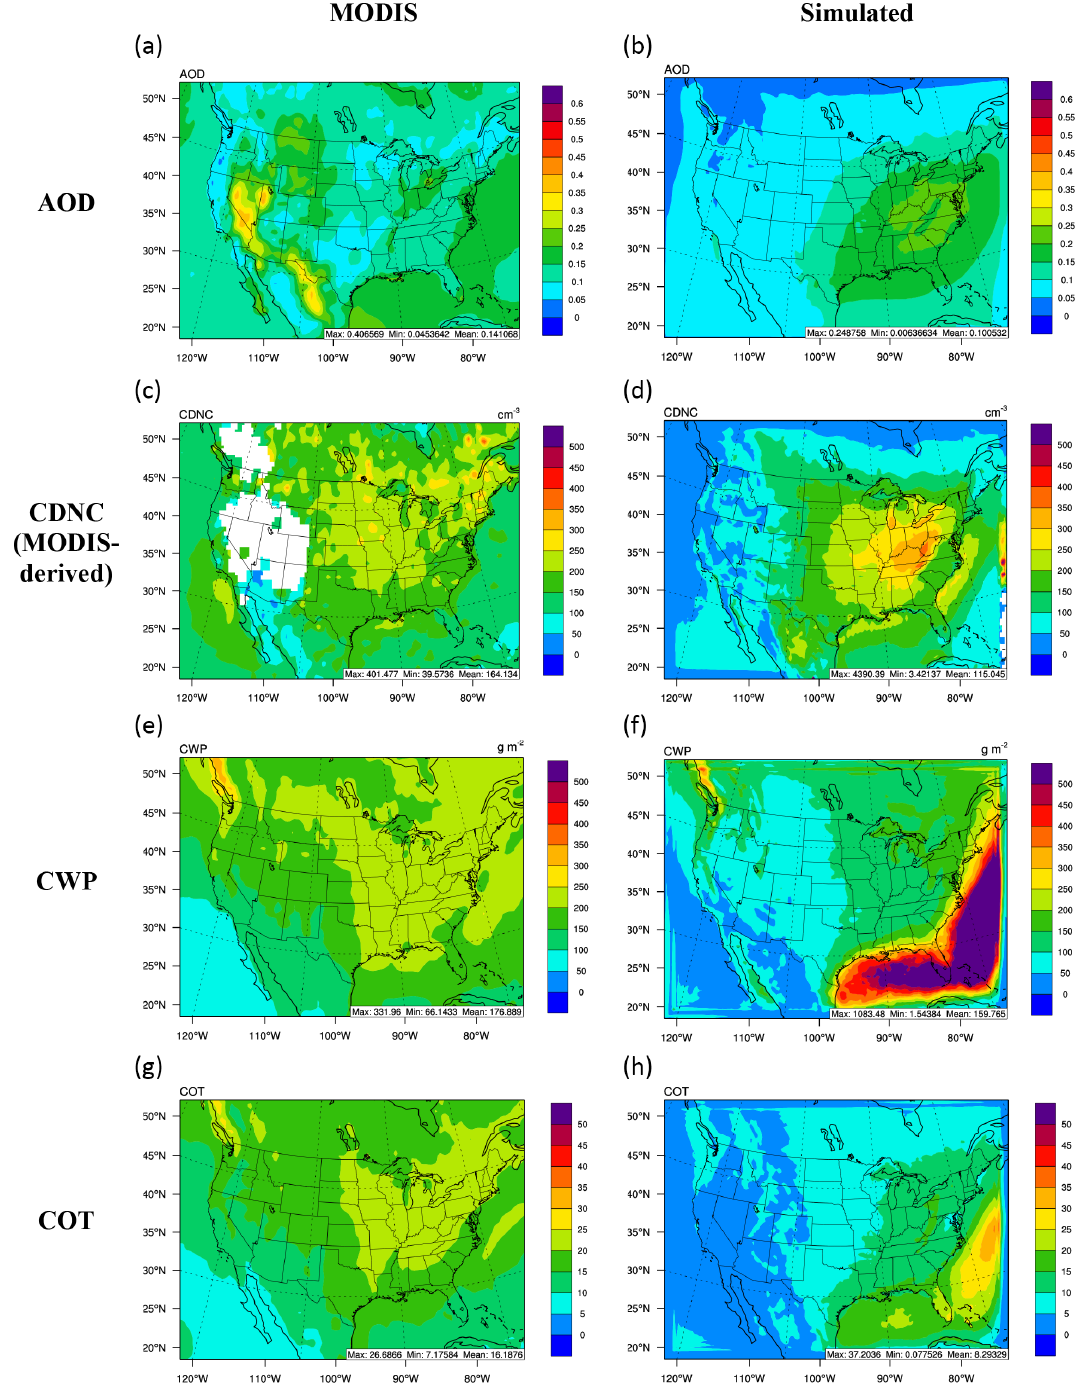
Figure 9. The 10-year averaged MODIS (left) vs. simulated (right) AOD ( a and b ), CDNC ( c and d ), CWP ( e and f ), and COT ( f and g ).